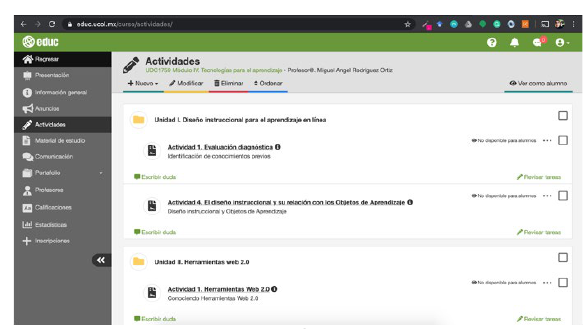
Figure 6. EDUC’s